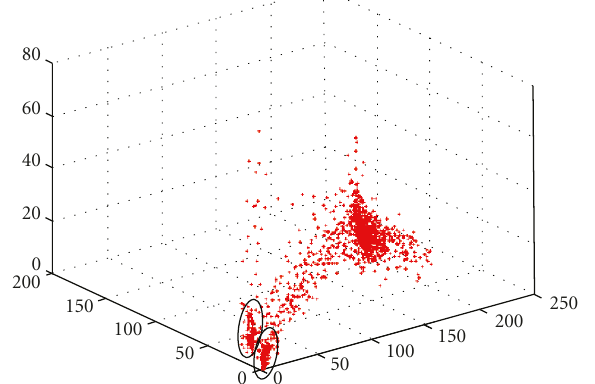
Figure 8: Colour distribution of 2400 blocks of 8 × 8 pixels taken from Figure 7(a). The data points in the circle closer to the origin correspond to the dark background of Figure 7(a) while the points in the other circle correspond to the leaves. The uncircled cluster corresponds to the flower